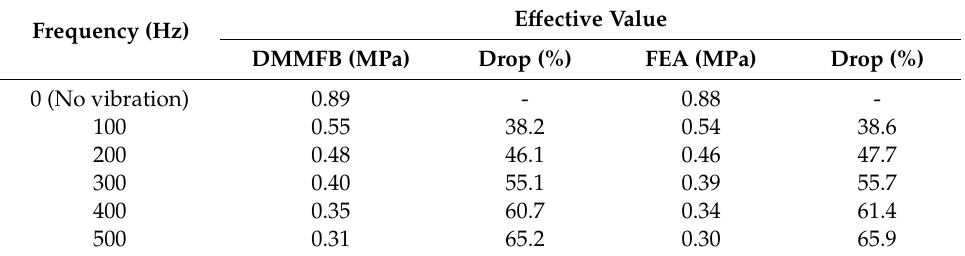
Table 8. Effective value of the shear stress without and with 0.35 g vibration applied at different frequencies.